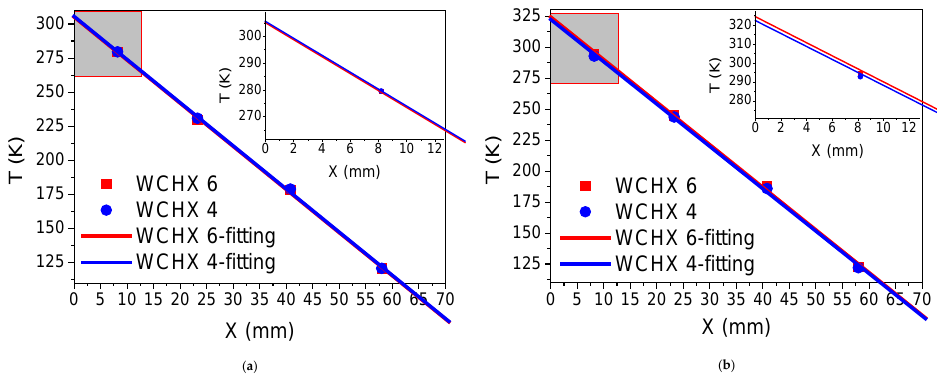
Figure 7. Dependence of relative Carnot efficiency on the input acoustic power for WCHXs 4 and 6.